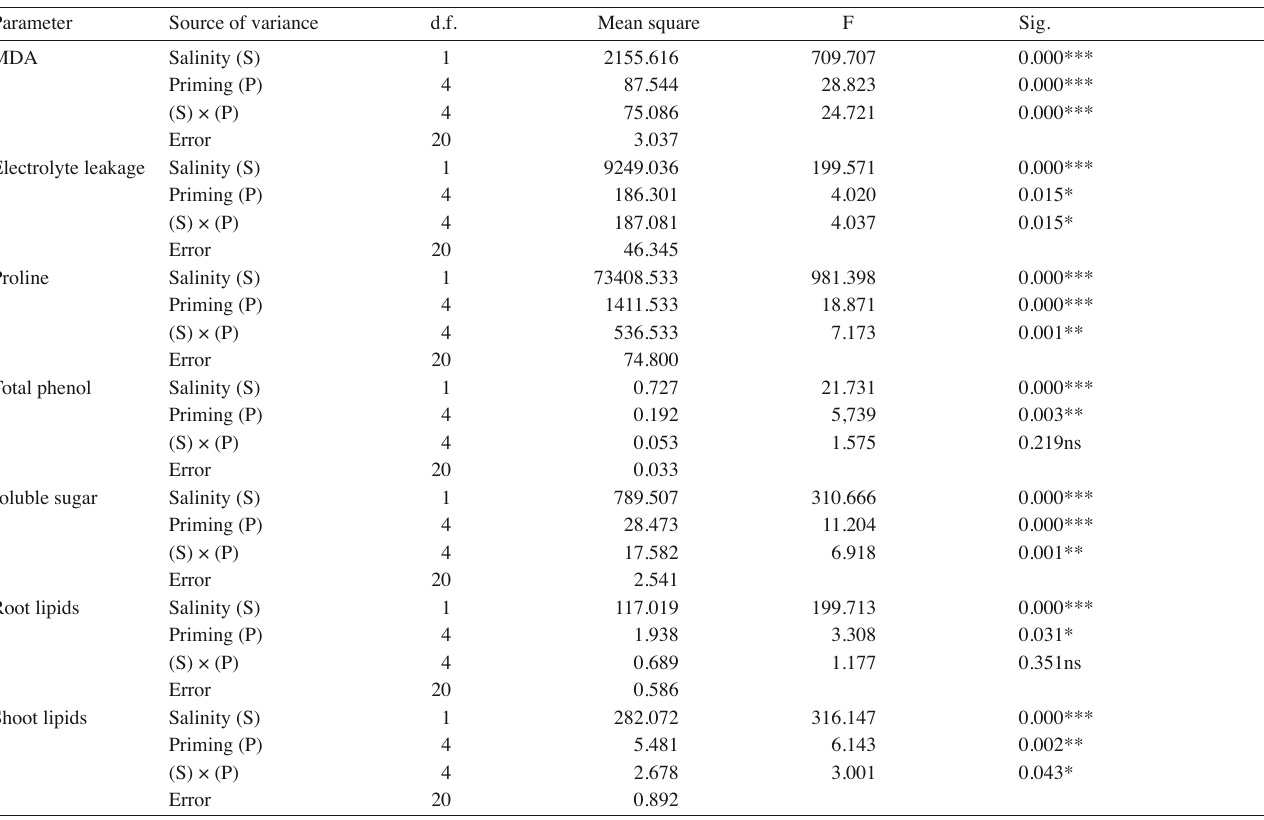
Tab. 3: Two-way ANOVA analysis of priming, salinity, and their interactions for the biochemical attributes (electrical conductivity, lipid peroxidation, proline content, total phenol, soluble sugar and lipids) of rice seedlings under salinity. Parameter Source of